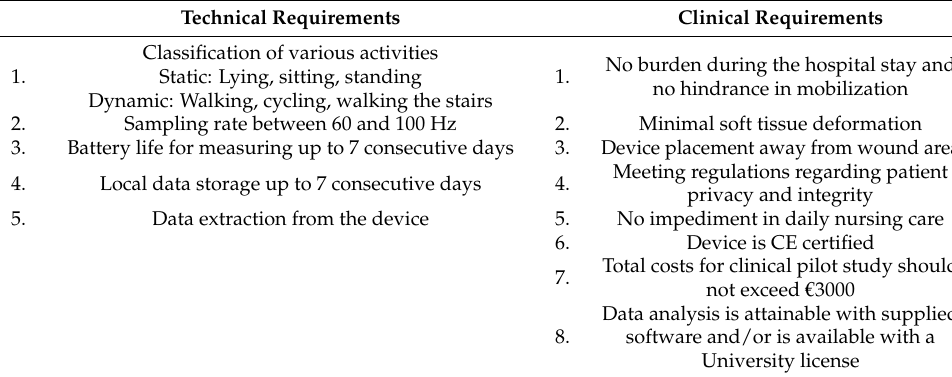
Table 1. Requirements for a device to classify in-patient physical activities after cardiac surgery, ranked from highest to lowest